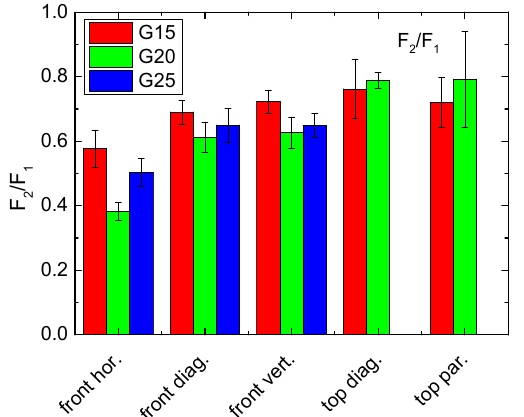
Figure 7. Force quotients of the samples under investigation, calculated from the forces measured along an impact of 8–10 mm during the second and the first cycle F 2 /F 1 .